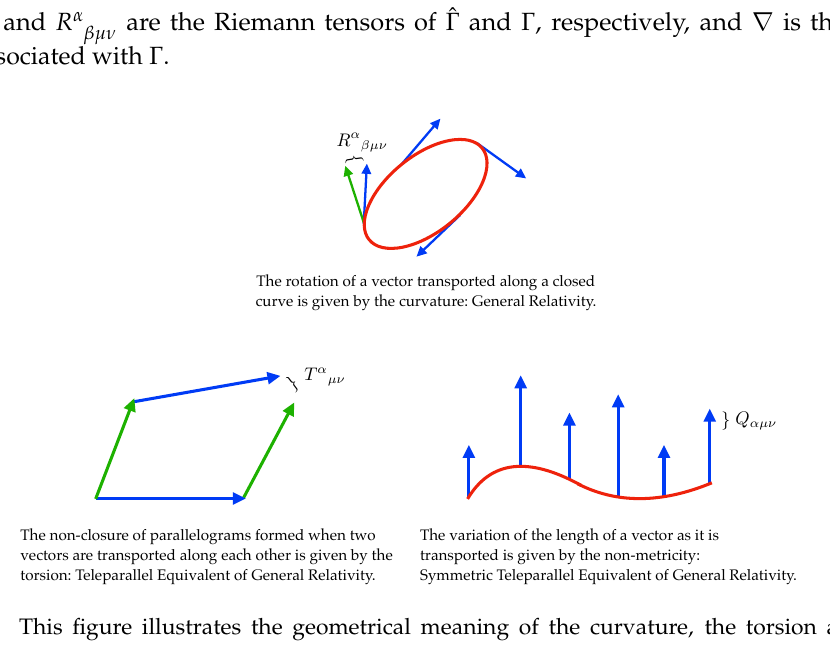
Figure 1. This figure illustrates the geometrical meaning of the curvature, the torsion and the non-metricity when the remaining objects vanish. We should emphasise that, when a vector is transported along a closed curve in a general geometry, it will acquire a rotation determined by R [ αβ ] µν and a length variation given by R ( αβ ) µν . It should be compared to Figure 2 where it is summarised how General Relativity admits equivalent representations in terms of these three geometrical